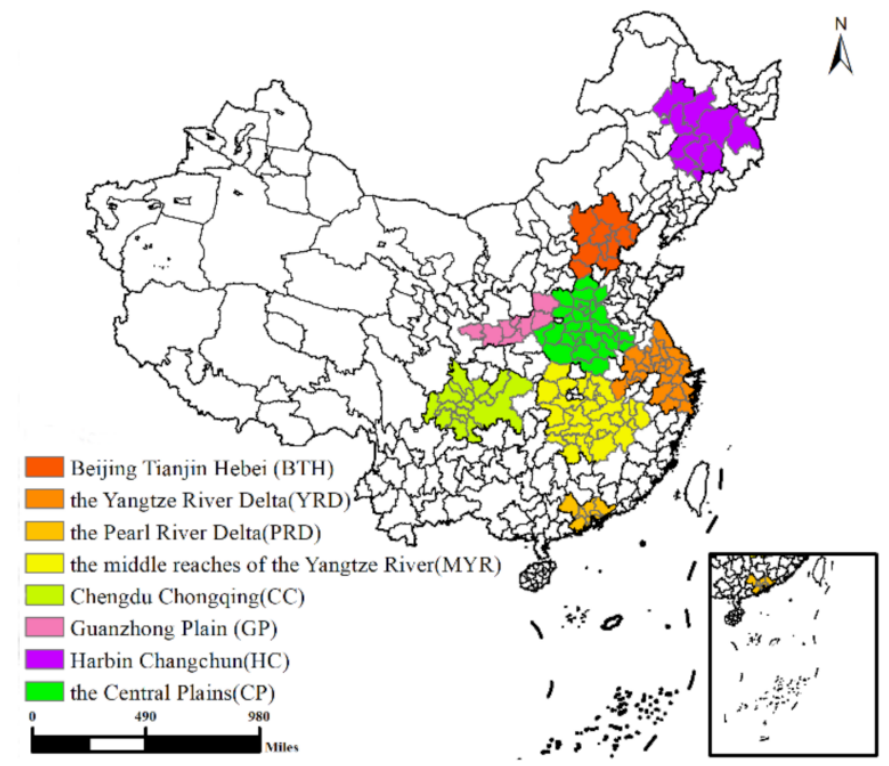
Figure 1. Location of the eight major urban agglomerations in